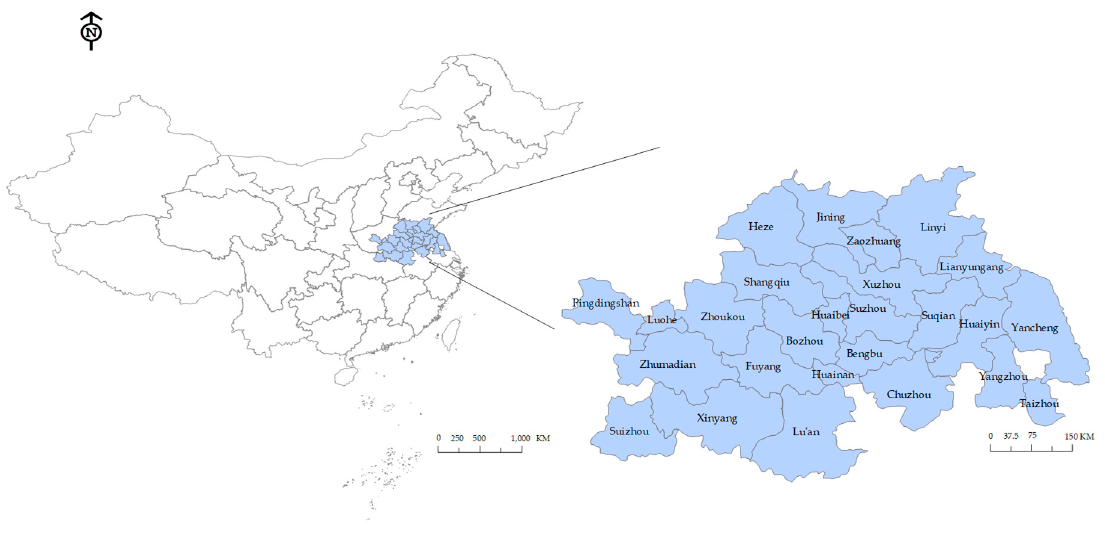
Figure 1. Range of the Huaihe River Eco-economic Belt.